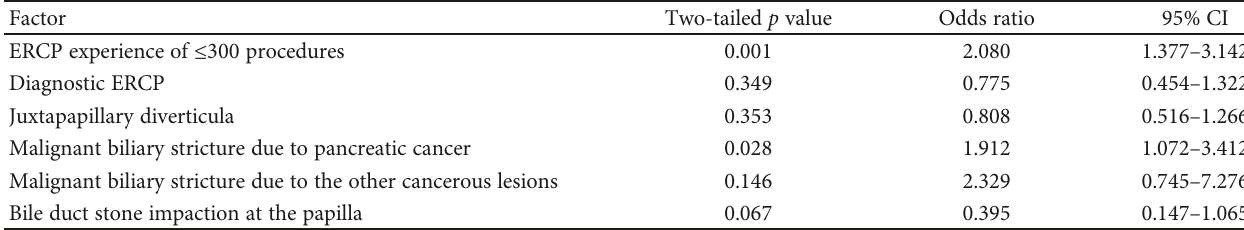
Table 3: Multivariate analysis of factors related to the L group.